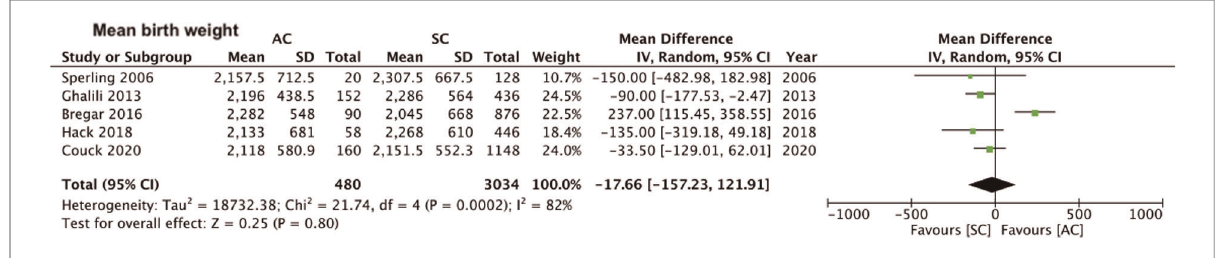
FIGURE 6 Meta-analysis of mean birth weight between assisted and spontaneously conceived monochorionic twin pregnancies.